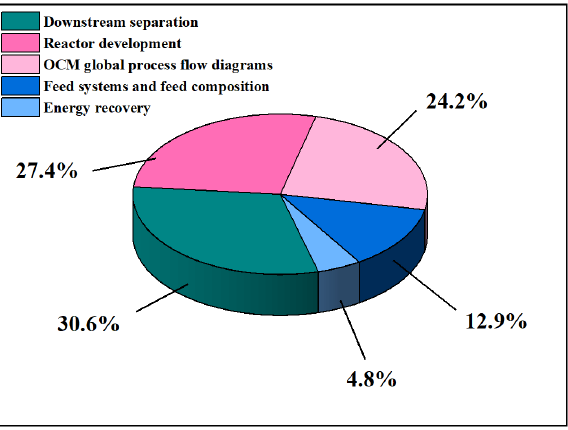
Figure 8. Distribution of subjects among extracted sample of patents related to OCM flow diagrams for ethylene production.